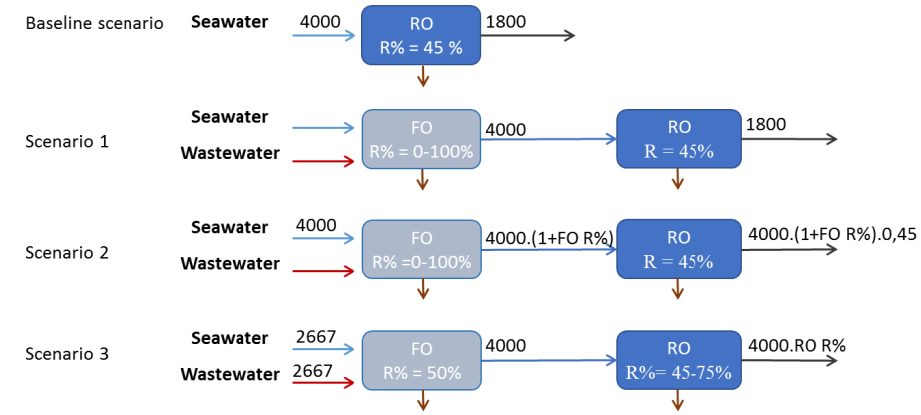
Figure 5. Examples of block flow diagrams of baseline (existing RO) and FO-RO with recovery (R%) for each scenario and impact on the produced water depending on FO recovery. All flow values are in m 3 ·h −1 , initial assumption of existing RO desalination plant with water production of 1800 m 3 ·h −1 and RO recovery of 45%